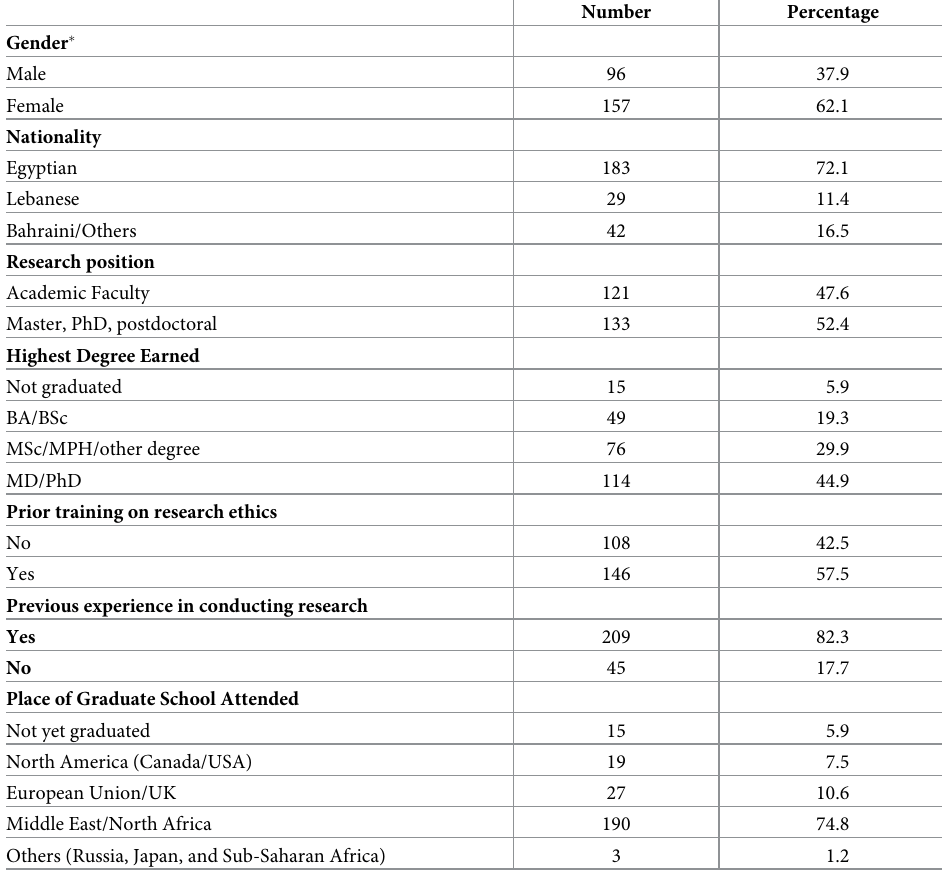
Table 2. Baseline characteristics of the study population N =